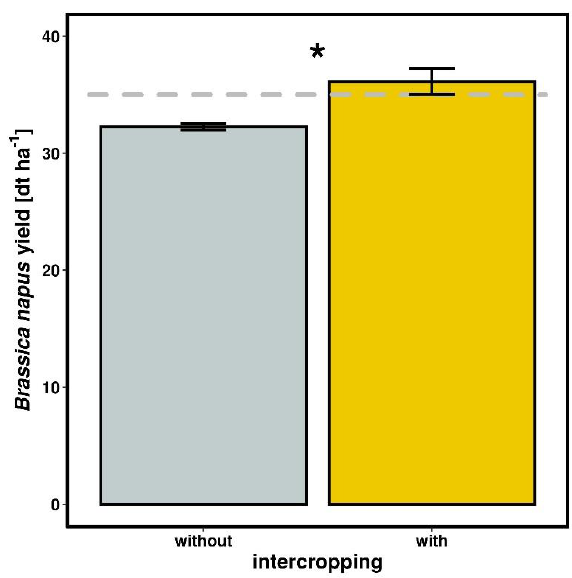
Figure 4. Intercropping supports Brassica napus yield when Vicia faba did not freeze over winter. Average yield of control (gray) and intercropped (yellow) B. napus . The dashed gray line represents the average Swiss B. napus yield for the same growing season. Bars represent SEM; * indicates p -values < 0.05.